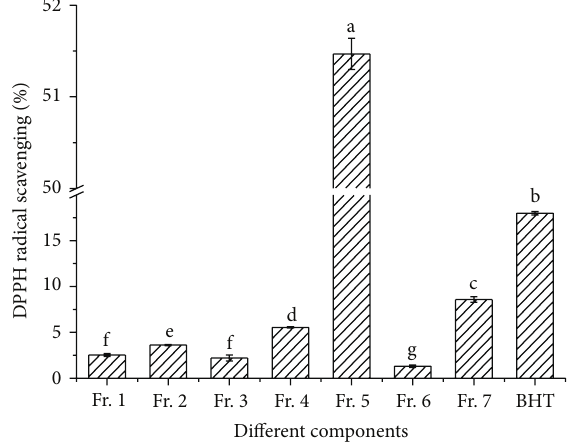
Figure 3: DPPH radical scavenging activity of 7